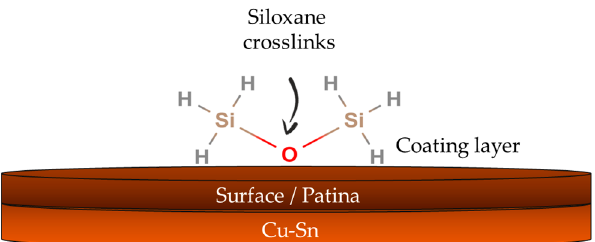
Figure 3. Siloxane cross-linking on the surface of a bronze sample. The mechanism allows the coating to adhere on the metal surface.